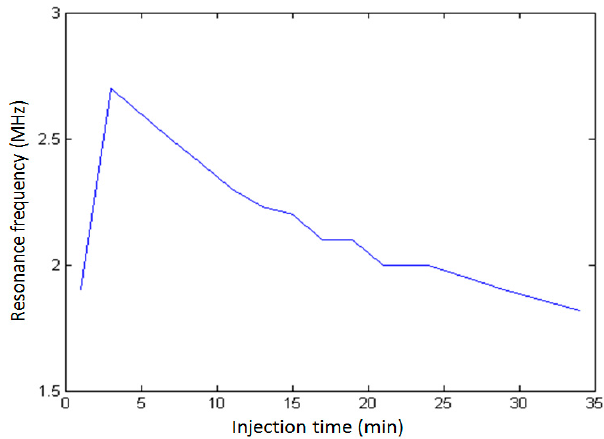
Figure 5. The UCA resonance frequency as a function of time from UCA injection.